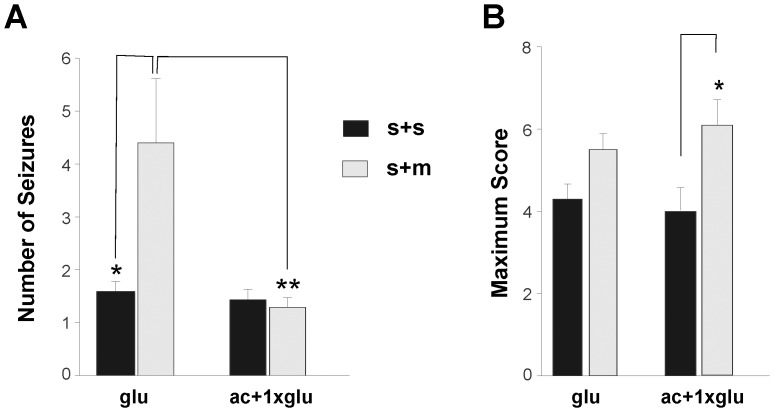
Effects of treatments (see Table 1) on the seizure scores and mortality in STZ rats.
A: Mean number of seizures in (*) glu rats: S+S: 1.6±0.2 (n = 17) and S+M: 4.4±1.2 (n = 5) (p<0.001); ac+1xglu rats: S+S: 1.3±0.2 (n = 8) and S+M: 1.4±0.2 (n = 8). (**) Significant difference also exists between glu rats: S+M and ac+1xglu rats: S+M (p<0.05) B: Mean maximum seizure score attained in glu rats: S+S: 4.3±0.4 (n = 17) and S+M: 5.5±0.4 (n = 5); (*) ac+1xglu rats: S+S: 4.0±0.6 (n = 8) and S+M: 6.1±0.6 (n = 8) (p<0.01).